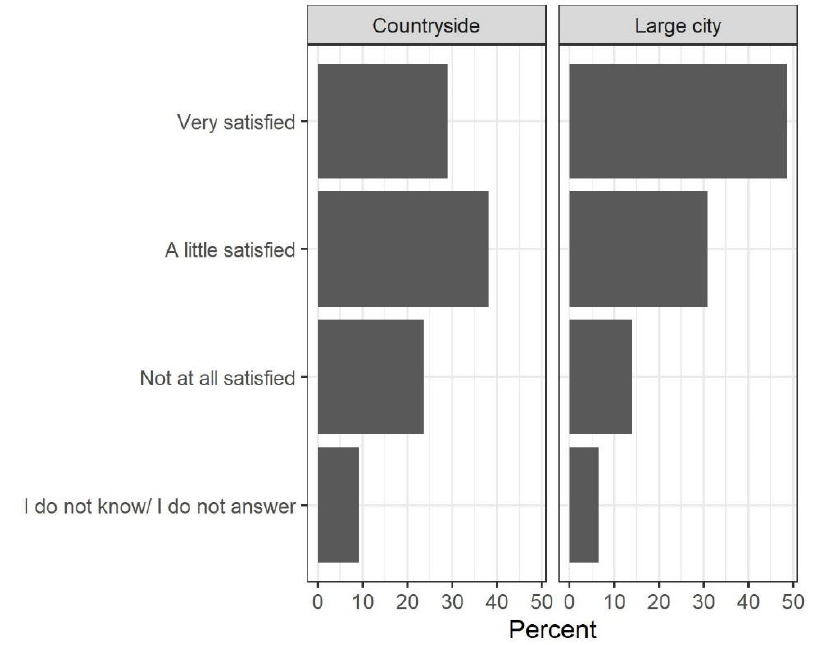
Figure A12. Cross-tabulation of attitudes of believers about the reopening of the Churches by city (% by city). Χ 2 = 12.7676, df = 3, p = 0.005.